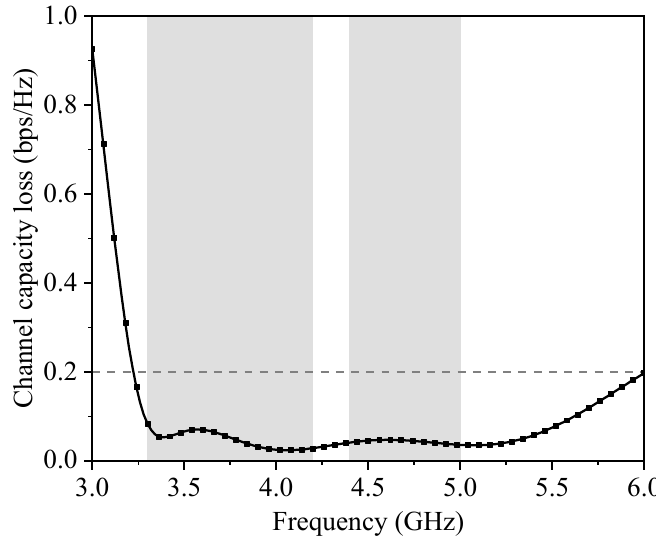
Figure 17. Computed CCL of the designed antenna.